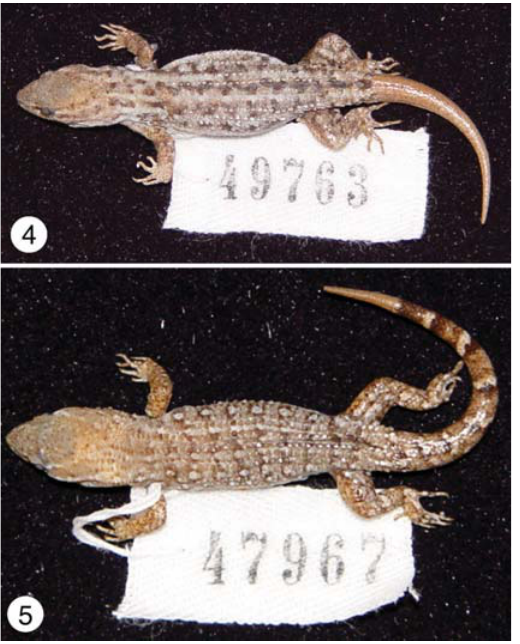
Fig. 4 – Gymnodactylus geckoides , MZUSP 49763, Exu, Pe; ocelli degenerated into longitudinal stripes. Fig. 5 – MZUSP 47967,Exu,Pe; ocelli degeneratedinto shortirregulartransverse